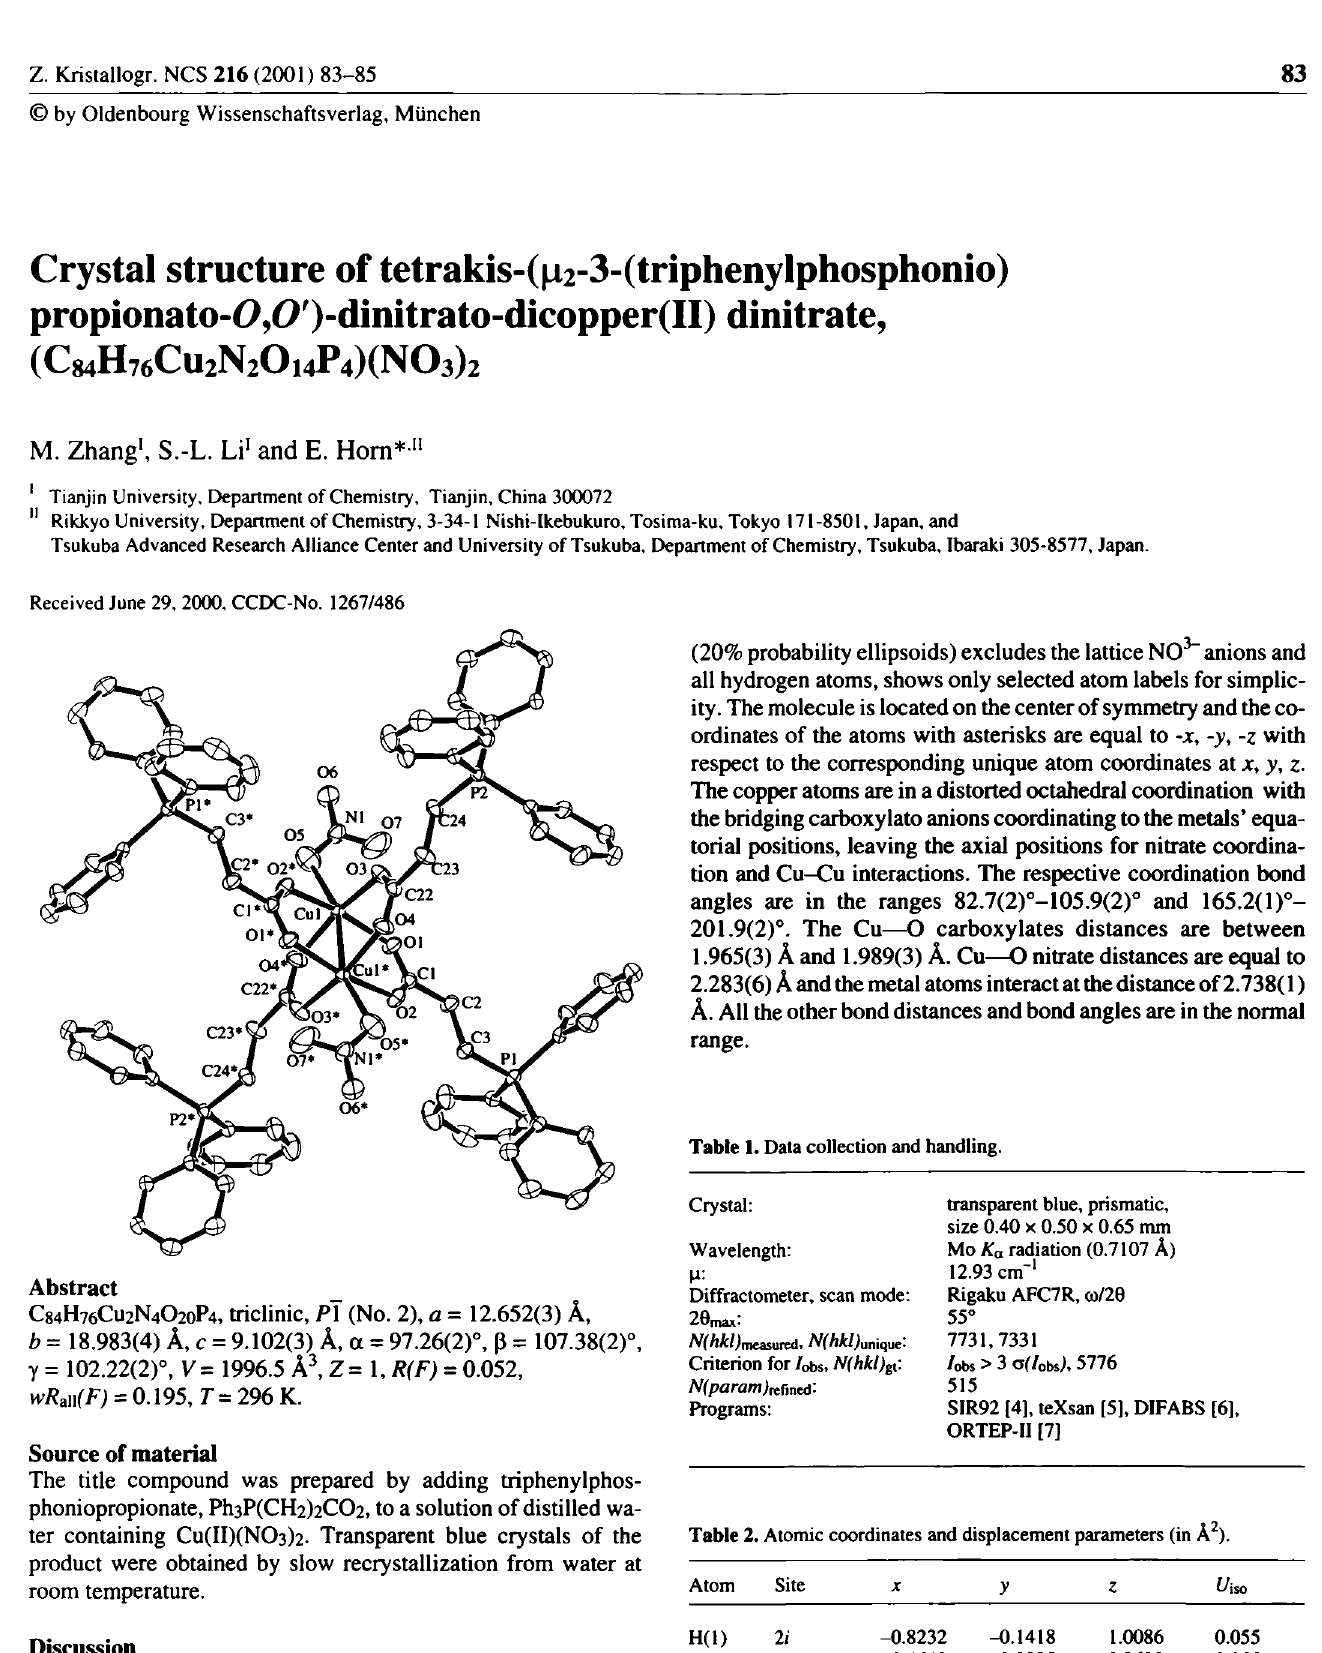
Table 2. Atomic coordinates and displacement parameters (in Ä 2